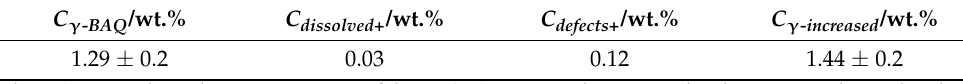
Table 4. The increase of carbon content in RA in BAP sample.